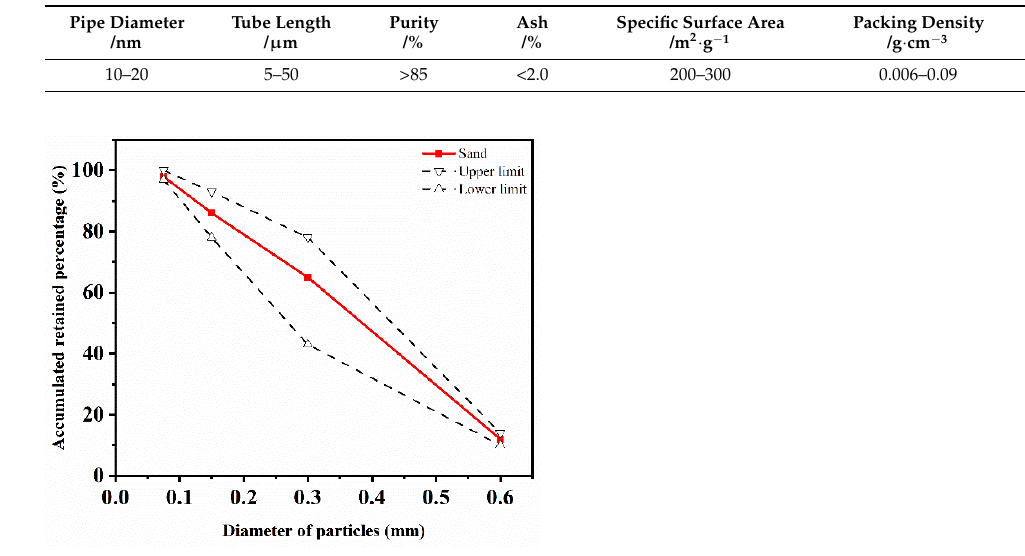
Table 1. Physical parameters of MWCNTs [26].